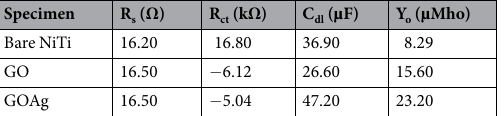
i corr ( µ A/cm 2 )